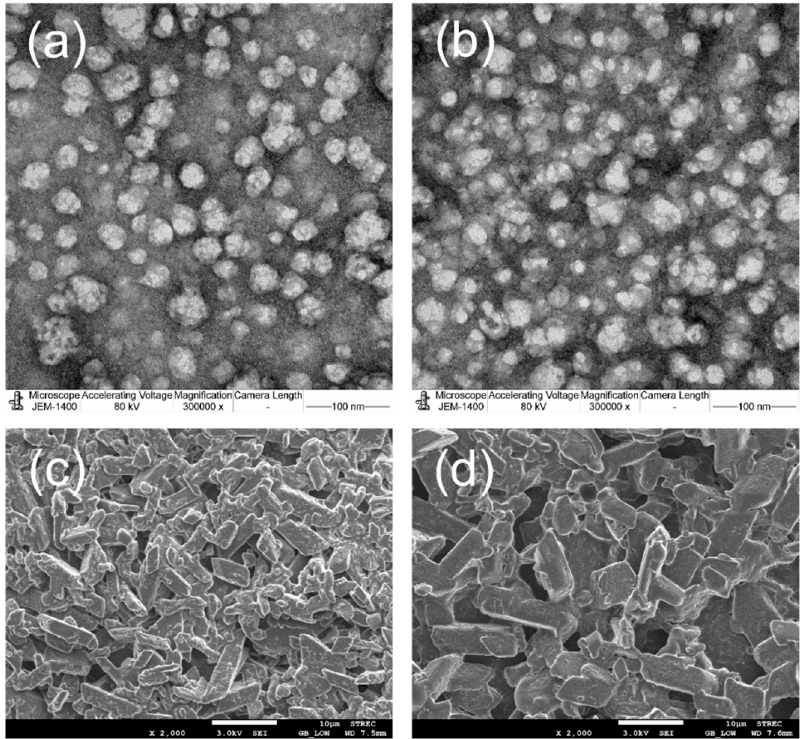
Figure 7. The TEM photographs of FE/RM β CD-loaded EuNPs, particularly ( a ) F6 and ( b ) F7, at magnification (100 nm bar). The SEM photographs of FE/RM β CD-loaded EuNPs, particularly ( c ) F6 and ( d ) F7, at magnification (×2000).